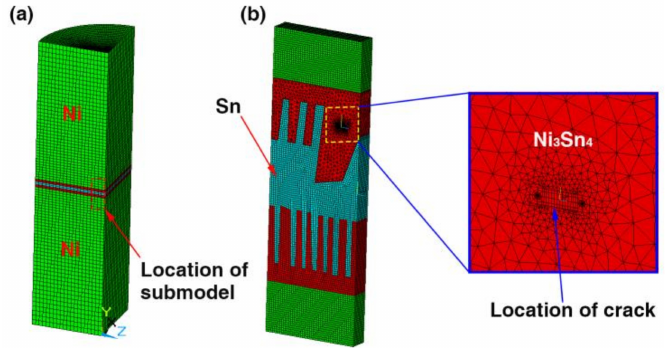
Figure 2. FE model of Ni / Sn / Ni micro-joints. ( a ) 2D axisymmetric global model; ( b ) sub-model containing rod-shaped IMCs.